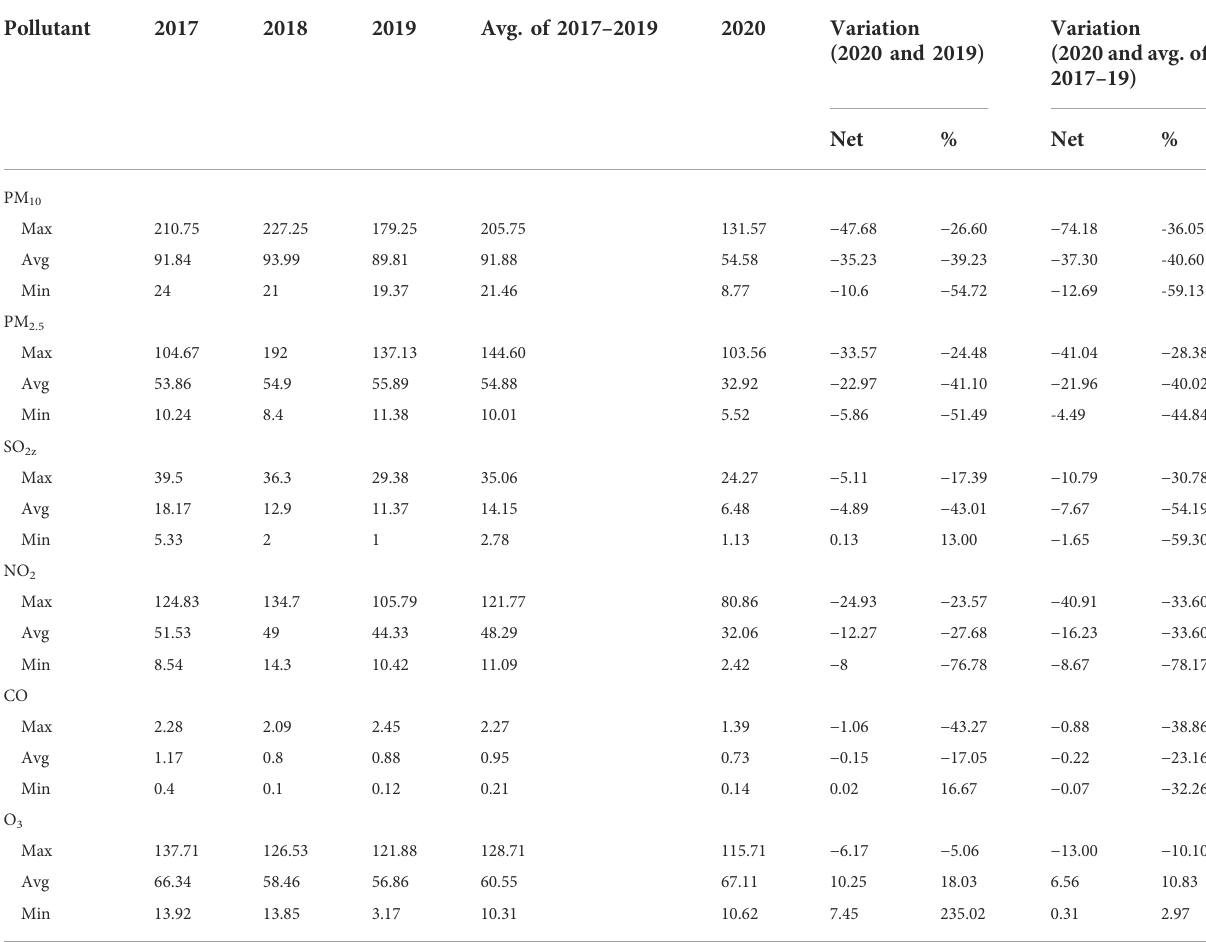
TABLE 2 Daily average concentration and variation of pollutants during 2017 – 20 in